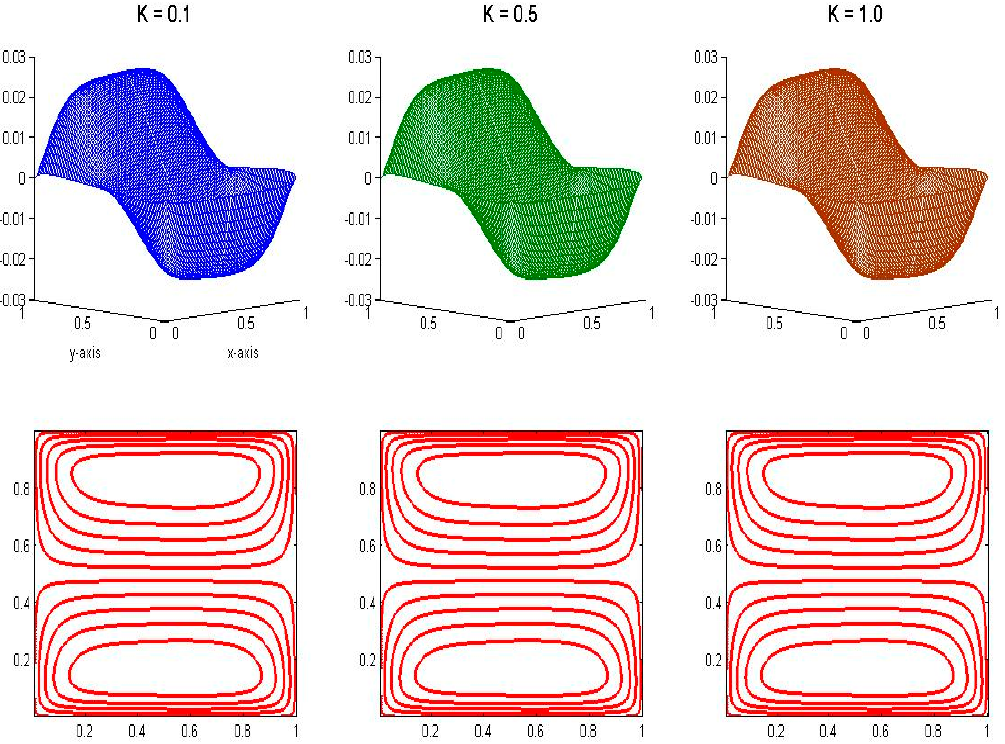
Figure 9. Velocity contours for altered ratio of thermal conductivities.